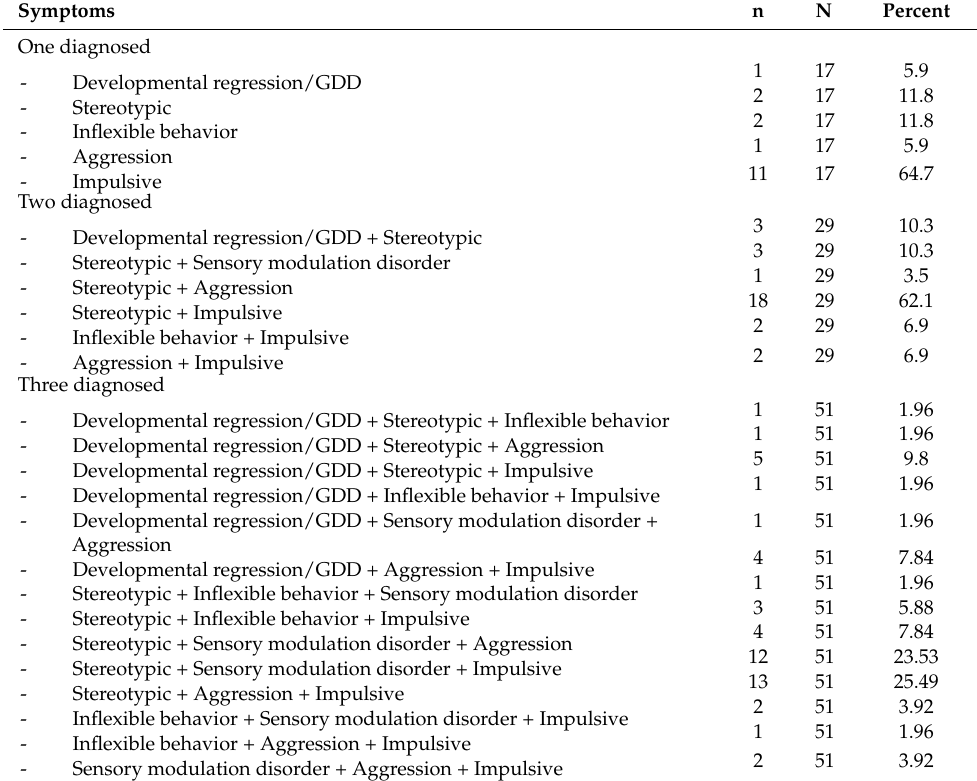
Table 2. ASD children presented with symptoms (n =